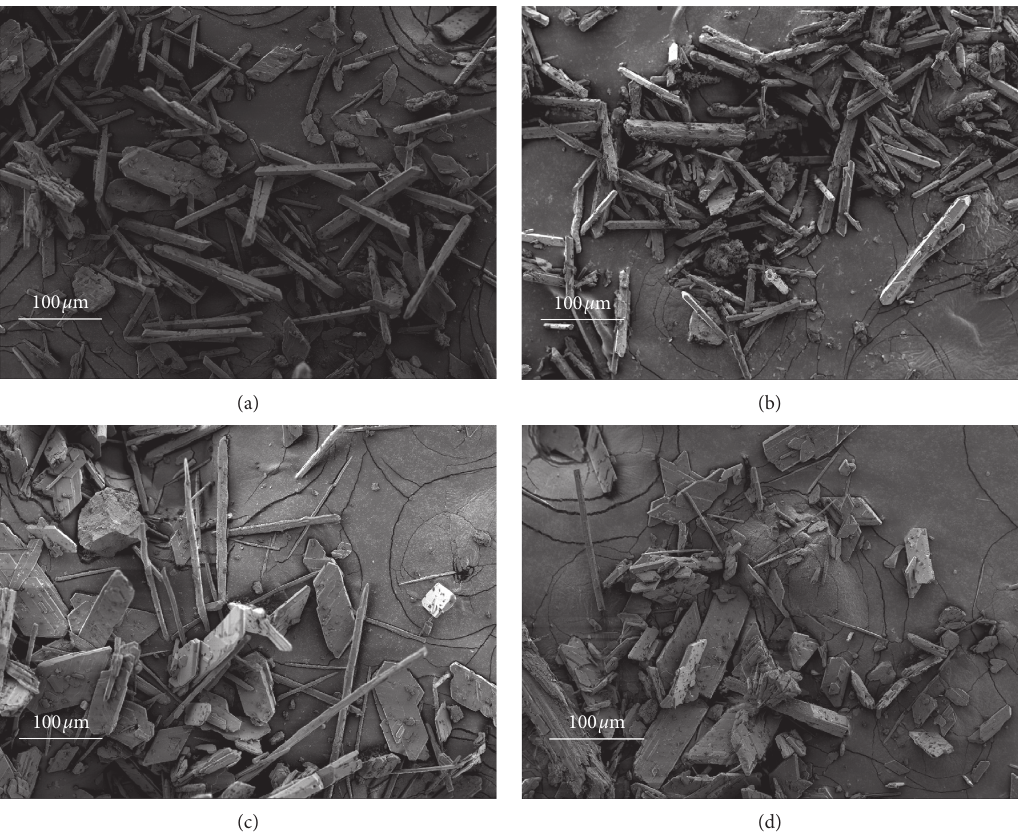
Figure 5: SEM photo (200 x ) at reaction times of (a) 0.5h; (b) 1h; (c) 1.5h; and (d) 2h when the aluminum ion concentration was